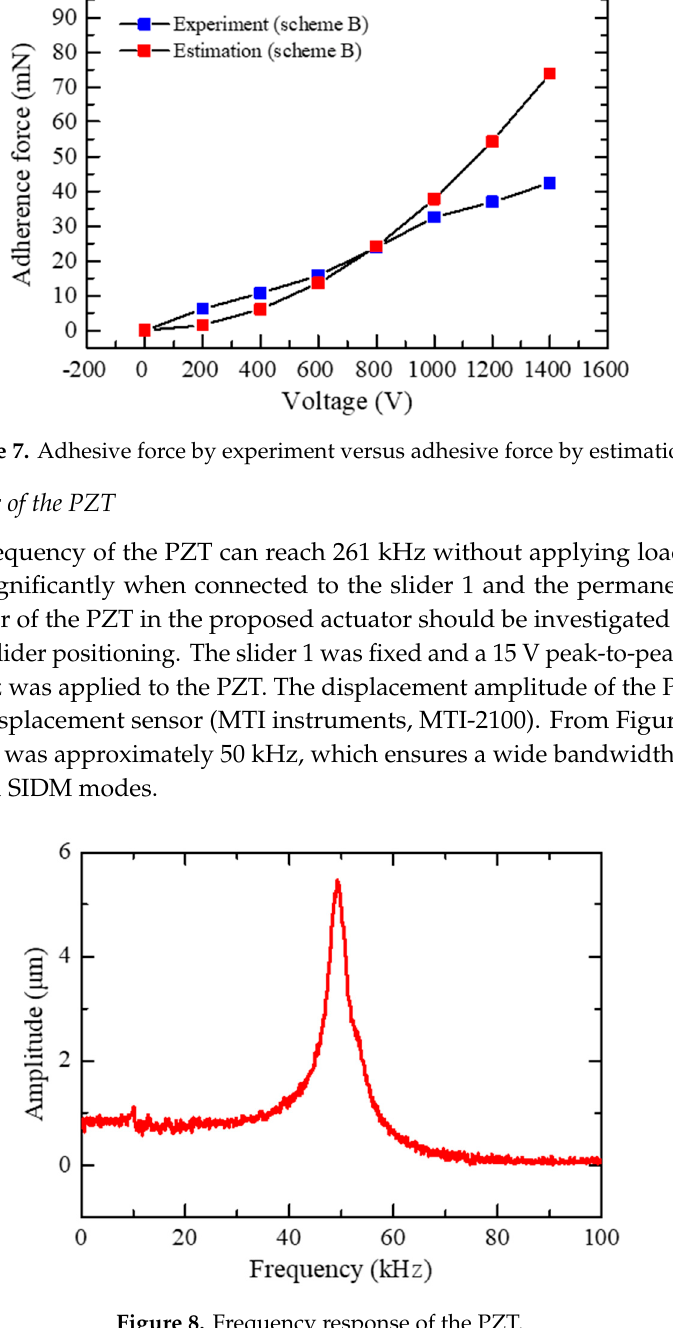
Figure 8. Frequency response of the PZT.